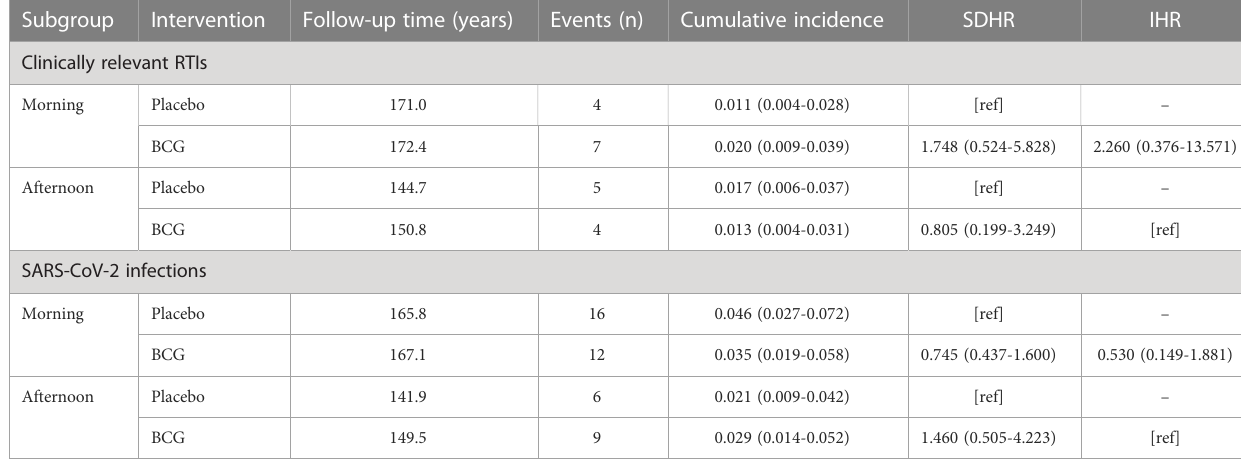
TABLE 2B Effect of morning and afternoon BCG vaccination compared to placebo in the period from six months to 12 months after vaccination. Subgroup